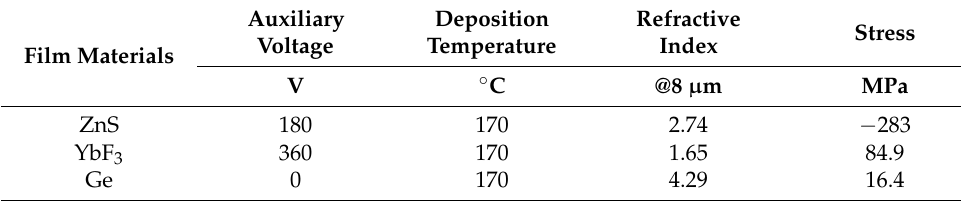
Auxiliary Deposition Voltage